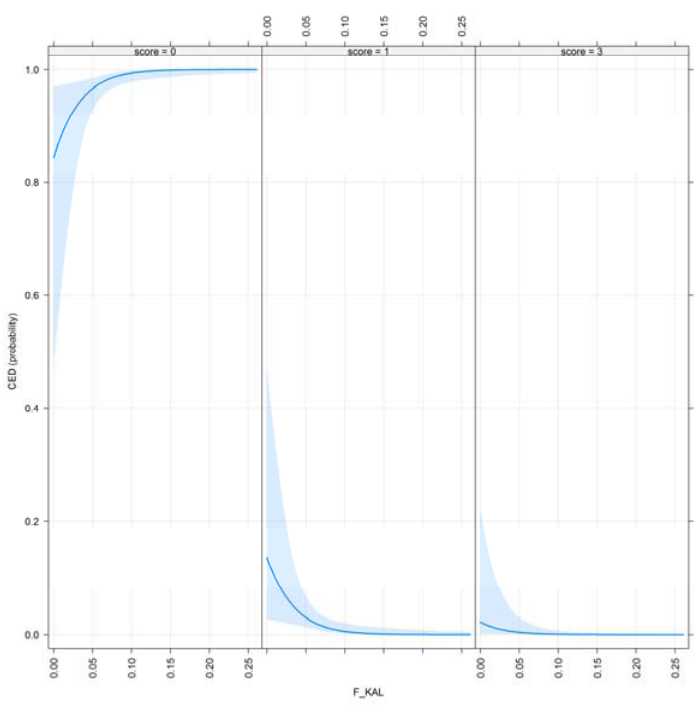
Animals 2020 , 10 , x FOR PEER REVIEW